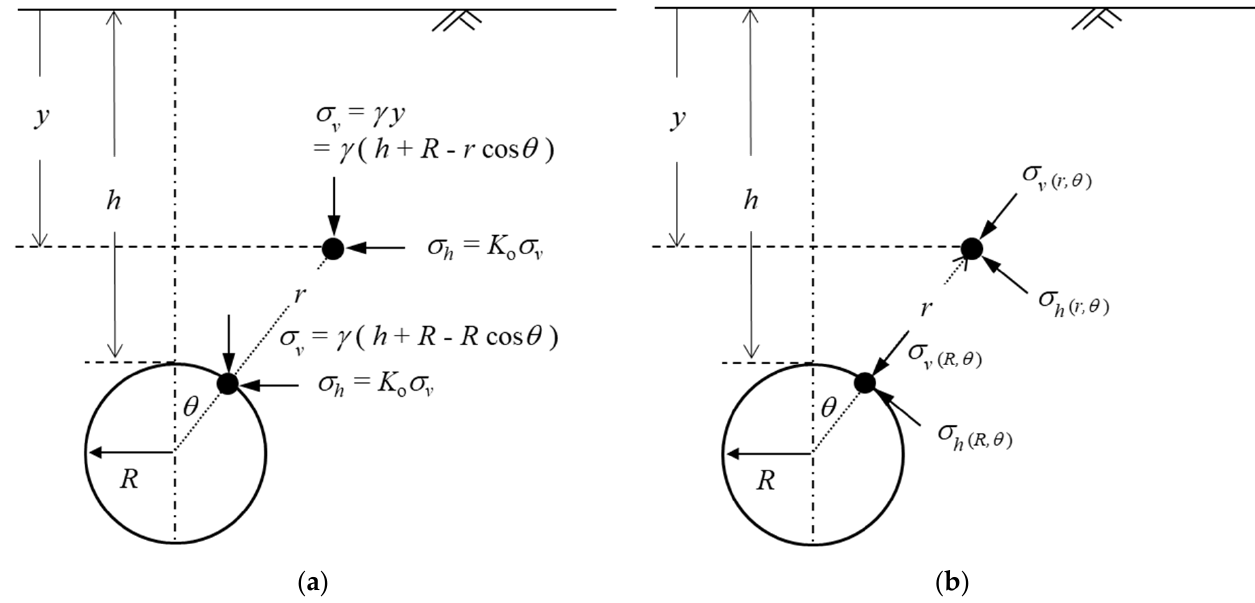
Figure 2. Schematic diagram of conversion of overburden pressure: ( a ) the Cartesian coordinate system and ( b ) the polar coordinate system.